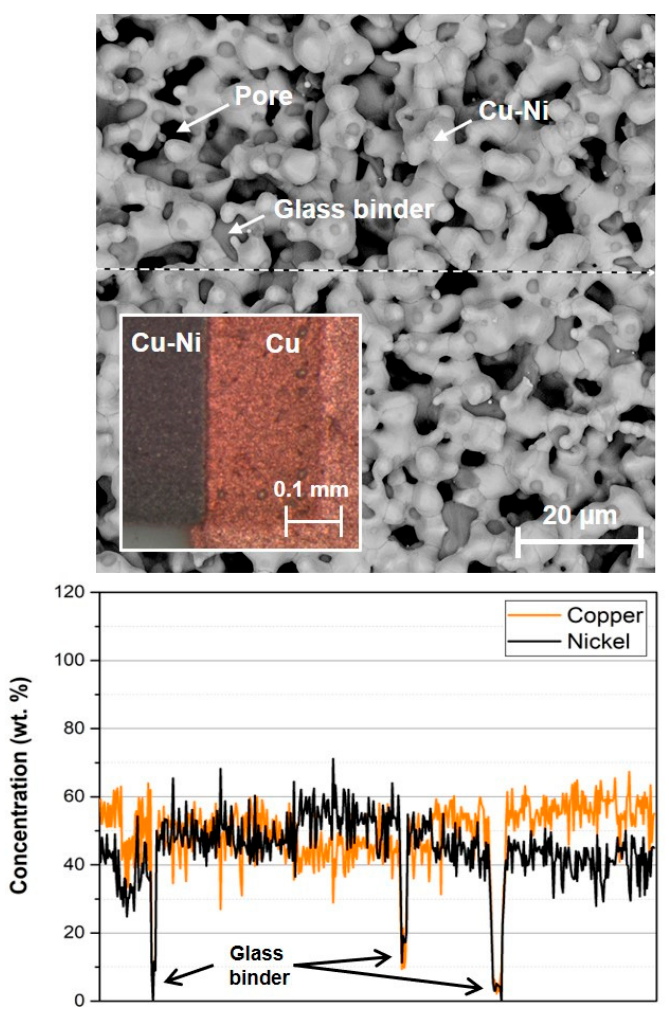
Figure 6. SEM image of fired copper-nickel thick film paste and EDS analysis of element distribution (dashed line represents the area where the EDS line scan was done).